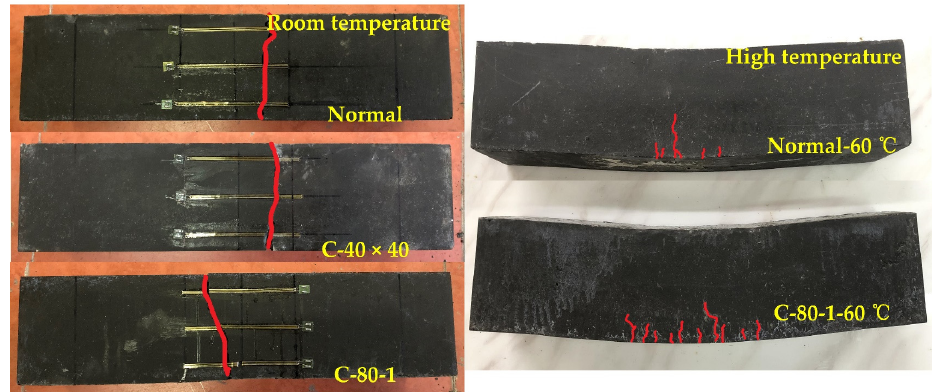
Figure 12. Failure patterns of specimens.